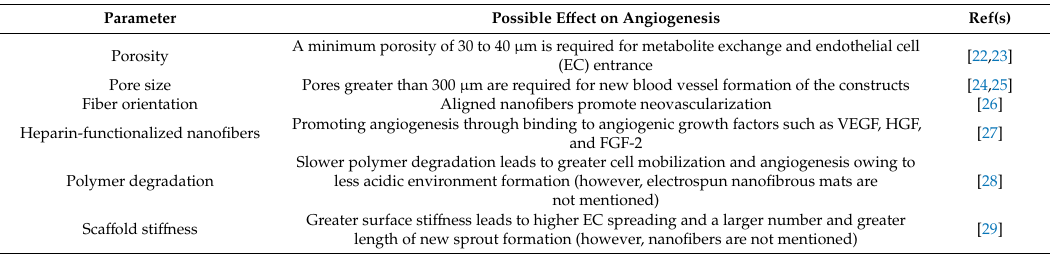
Table 2. Parameters of fibrous sca ff olds that may a ff ect